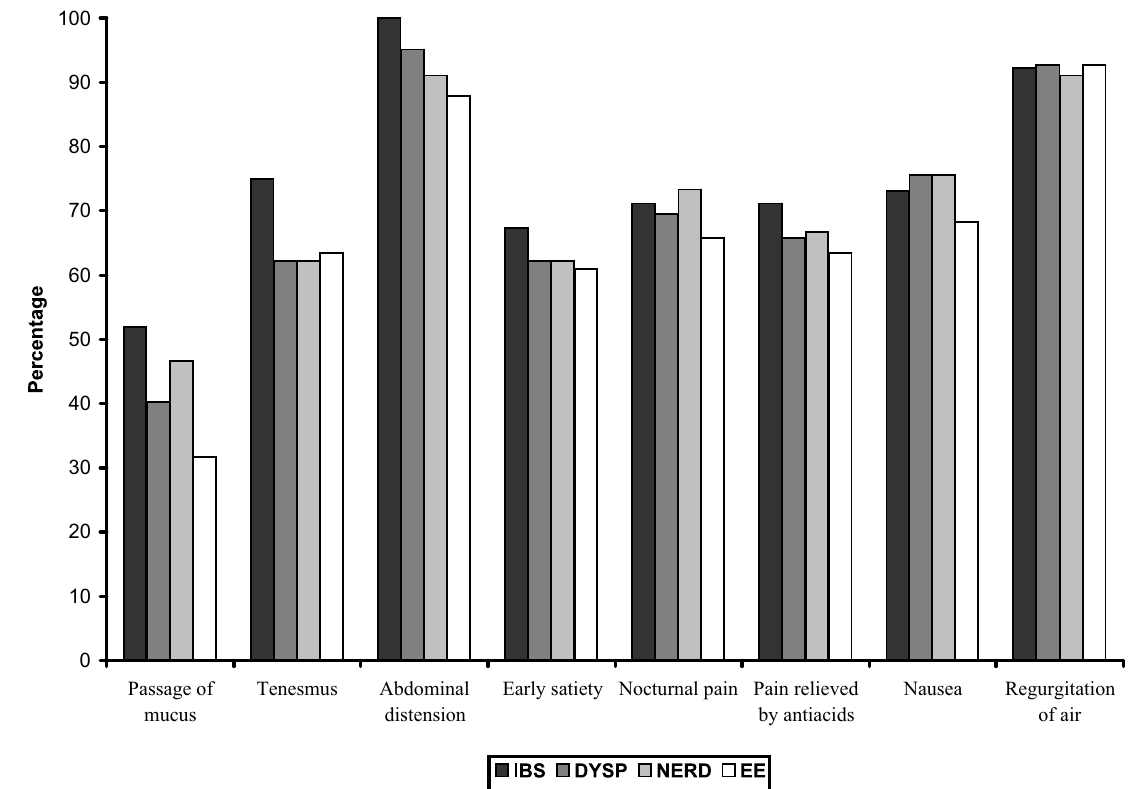
Fig. 3 – Upper and lower GI symptoms shared by 118 patients with irritable bowel syndrome (IBS), dyspepsia (DYSP), non-erosive reflux disease (NERD)anderosiveesophagitis(EE),butwithoutstatisticalsignificance. Thefiguredepictsthepercentageofpatientshavingindividualsymptoms in each